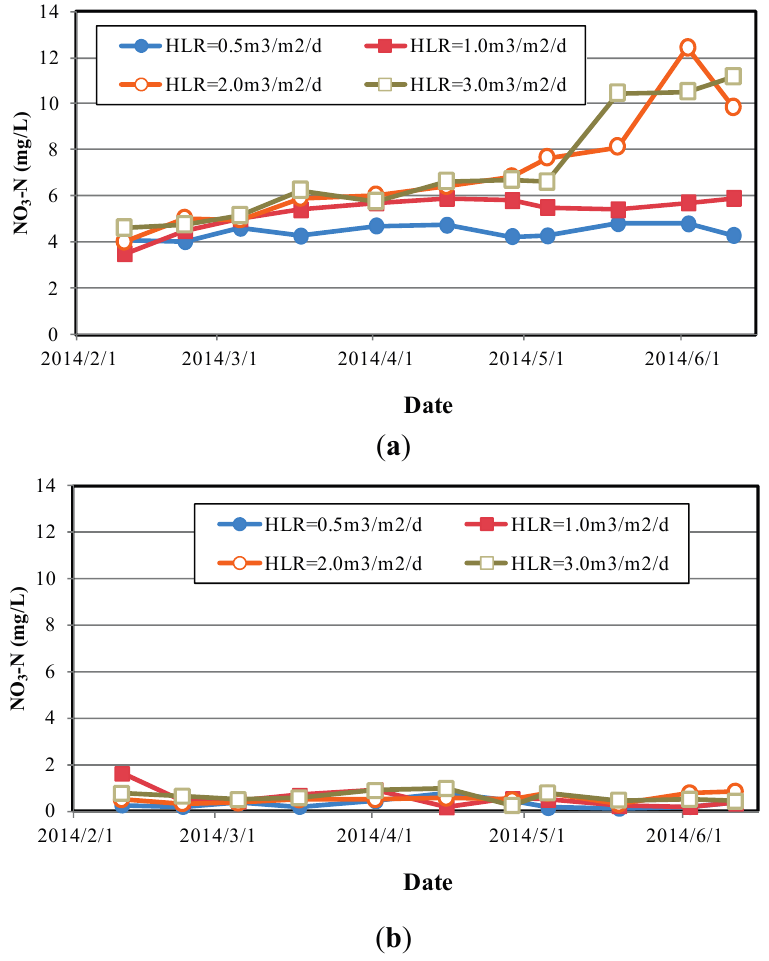
Figure 9. Changes in outflow NH3-N concentrations under various HLR conditions. ( a ) System B (expanded clay aggregate); ( b ) System A